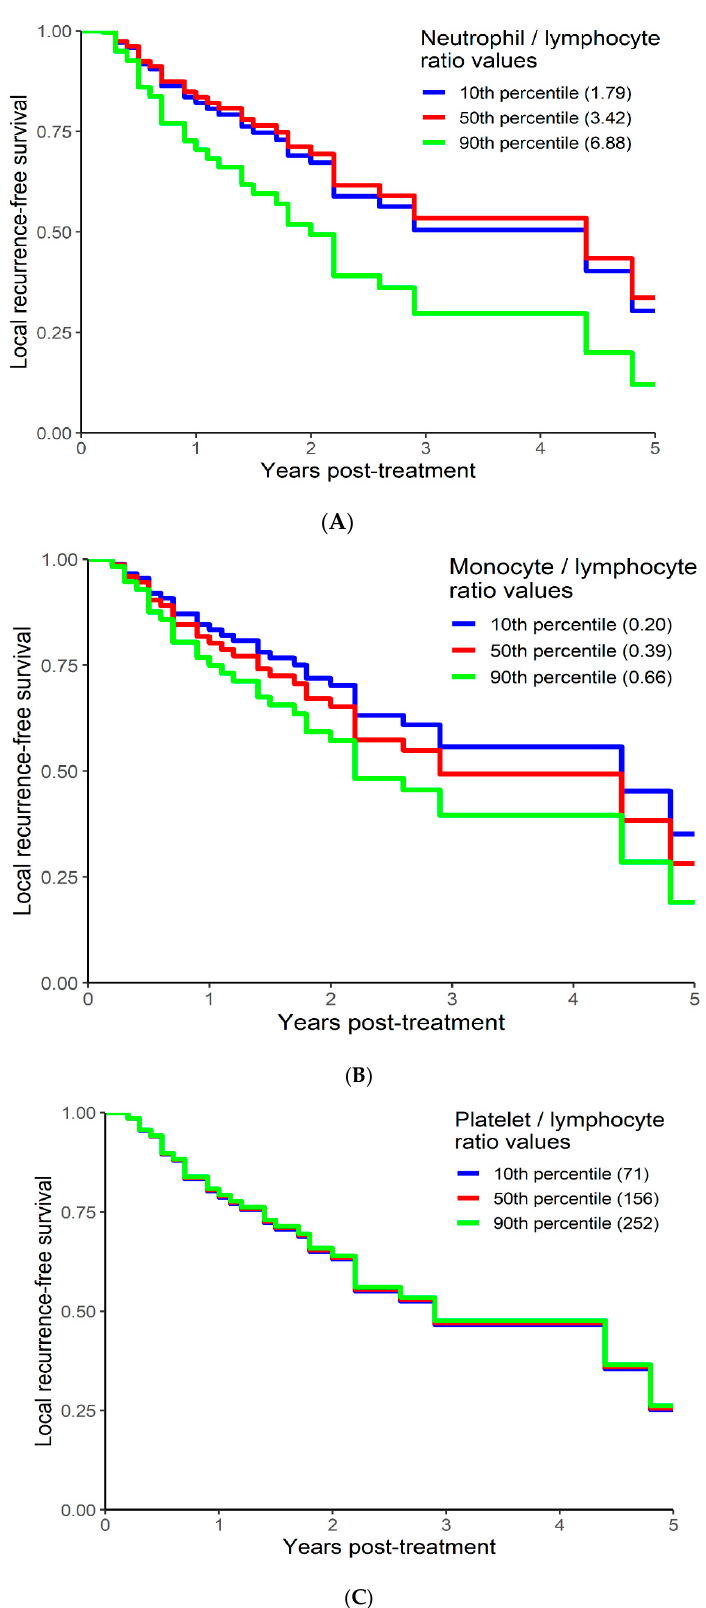
Figure 6. Risk of LRFS by NLR.